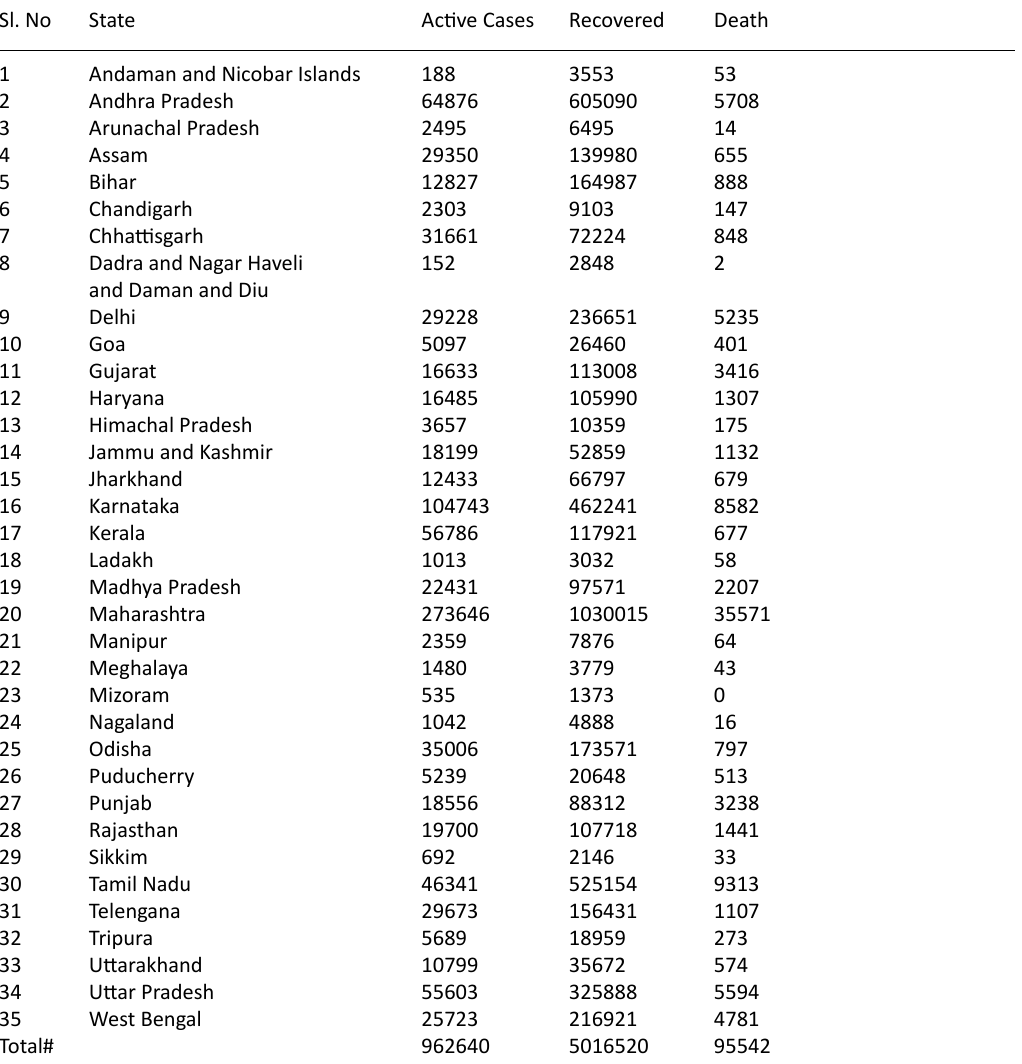
table 2. COVID-19 INDIA as on: 28 September 2020 (https://www.mohfw.gov.in/) Sl.